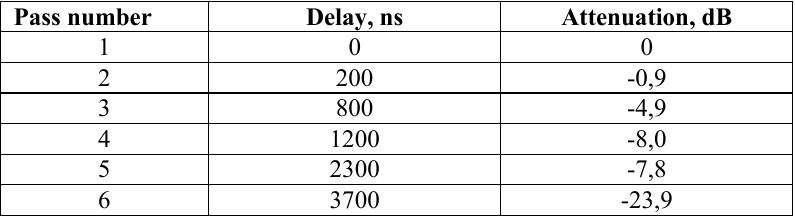
Table 2. Parameters of the multipath channel used in the